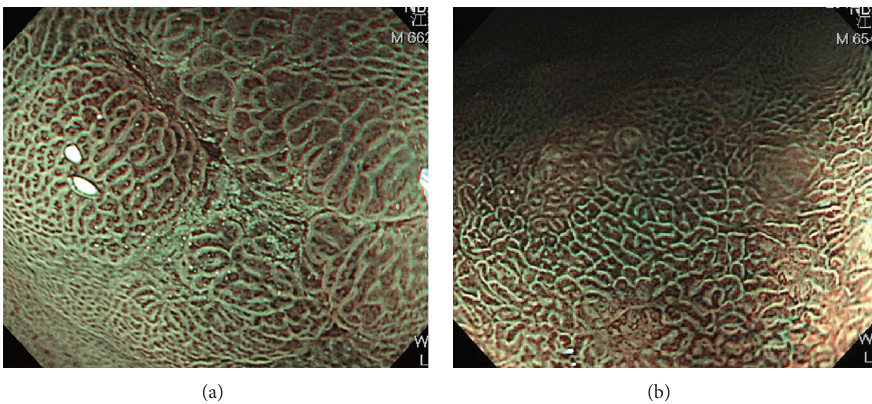
Figure 9: Magnifying endoscopy with narrow-band imaging of intestinal metaplasia change of gastric mucosa shows light blue crest sign (a fine, blue-white line on the crests of the epithelial